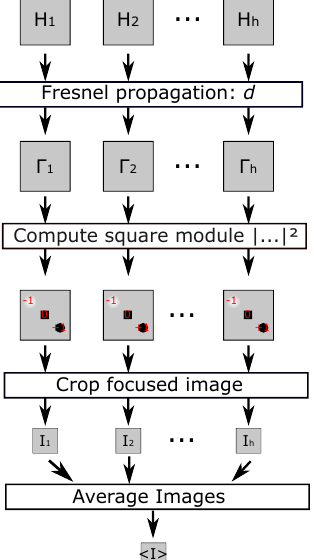
Figure 2. Pipeline for hologram reconstruction and speckle